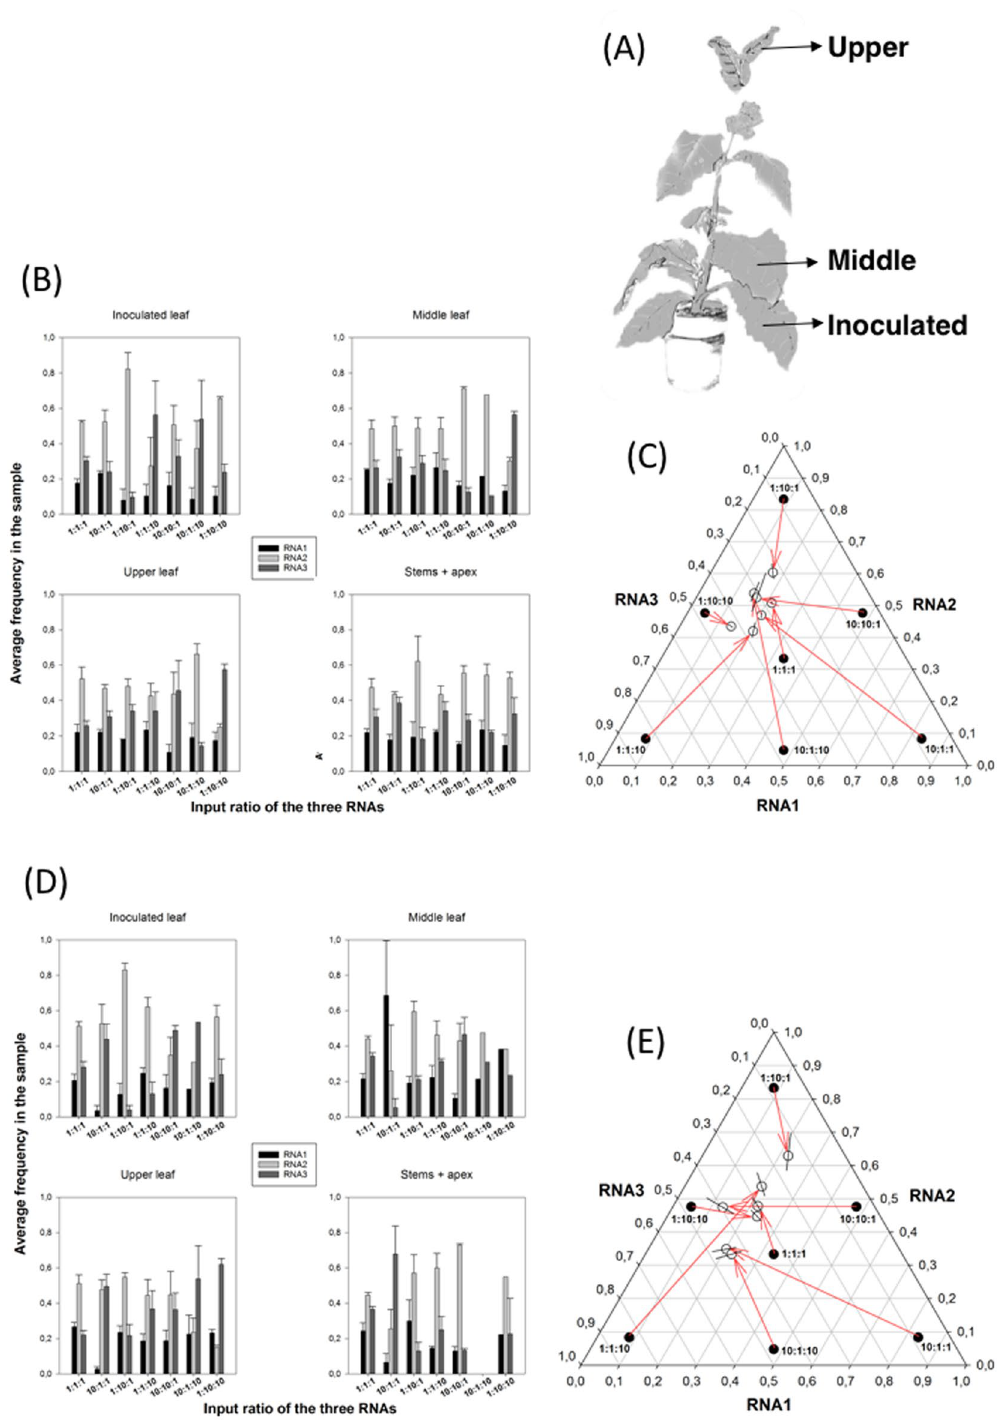
Figure 1. Effect of differences in the input ratio of RNA segments on the outcome of AMV infection. ( A ) Scheme of the sampling process, with indication of the three leafs sampled. ( B ) Experimental determinations (by RT-qPCR) of the frequency of each one of the three RNA segments in samples of total RNA for different input ratios. Bars represent the mean of n = 3 plants; error bars represent ± 1 SEM. ( C ) Normalized frequency ternary plot showing the estimated SGF . Solid circles represent the indicated inoculation rates. Open circles show the marginal mean estimates of relative ratios at the end of the experiment corresponding to each input ratio. Lines crossing the open circles represent the 95% Cis. Red arrows connect initial and final ratios. ( D ) As in ( B ) but determined for encapsidated RNAs. ( E ) As in ( C ) but for encapsidated